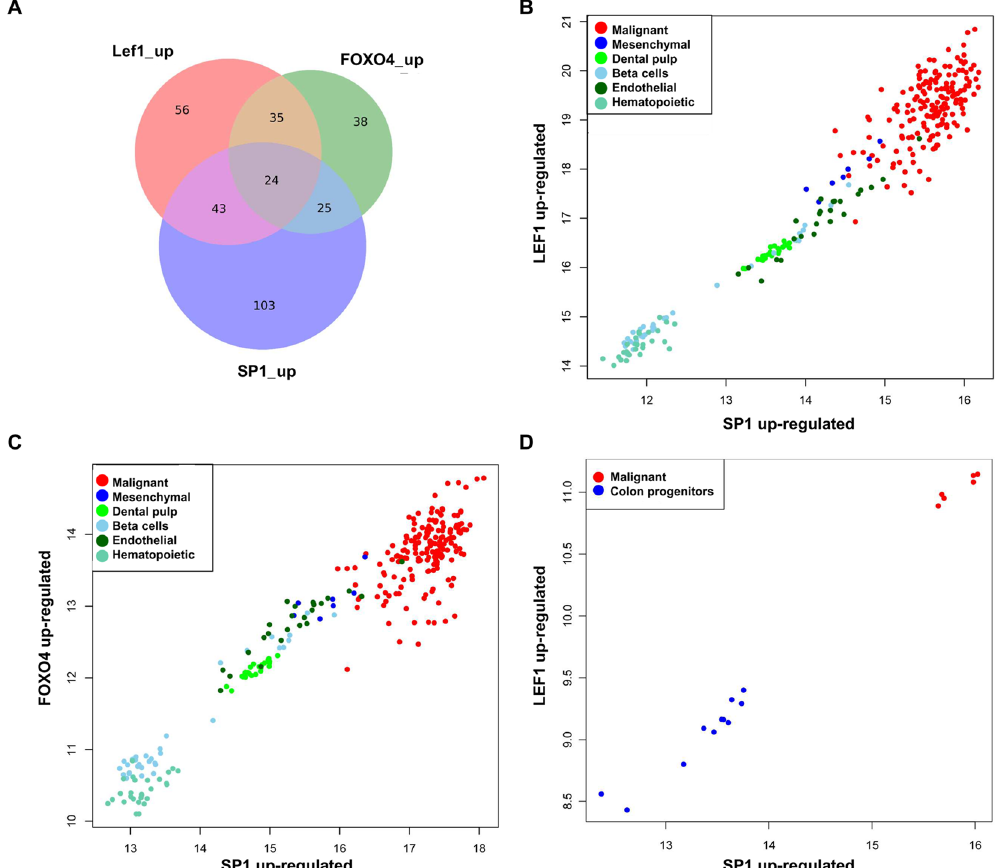
Figure 2. Expression of the SP1, FOXO4, and LEF1 regulated genes. Overlap between genes up-regulated in cancer cell lines and regulated by each of the three transcription factors (according to GeneCodis) ( A ). Correlation between the aggregated expressions of SP1 up-regulated genes and LEF1 up-regulated genes ( B ). Correlation between the aggregated expressions of SP1 up-regulated genes and FOXO4 up-regulated genes ( C ). Correlation between the aggregated expressions of SP1 up-regulated genes and LEF1 up-regulated genes in colon stem cells and the colon cancer cell line HT29 ( D